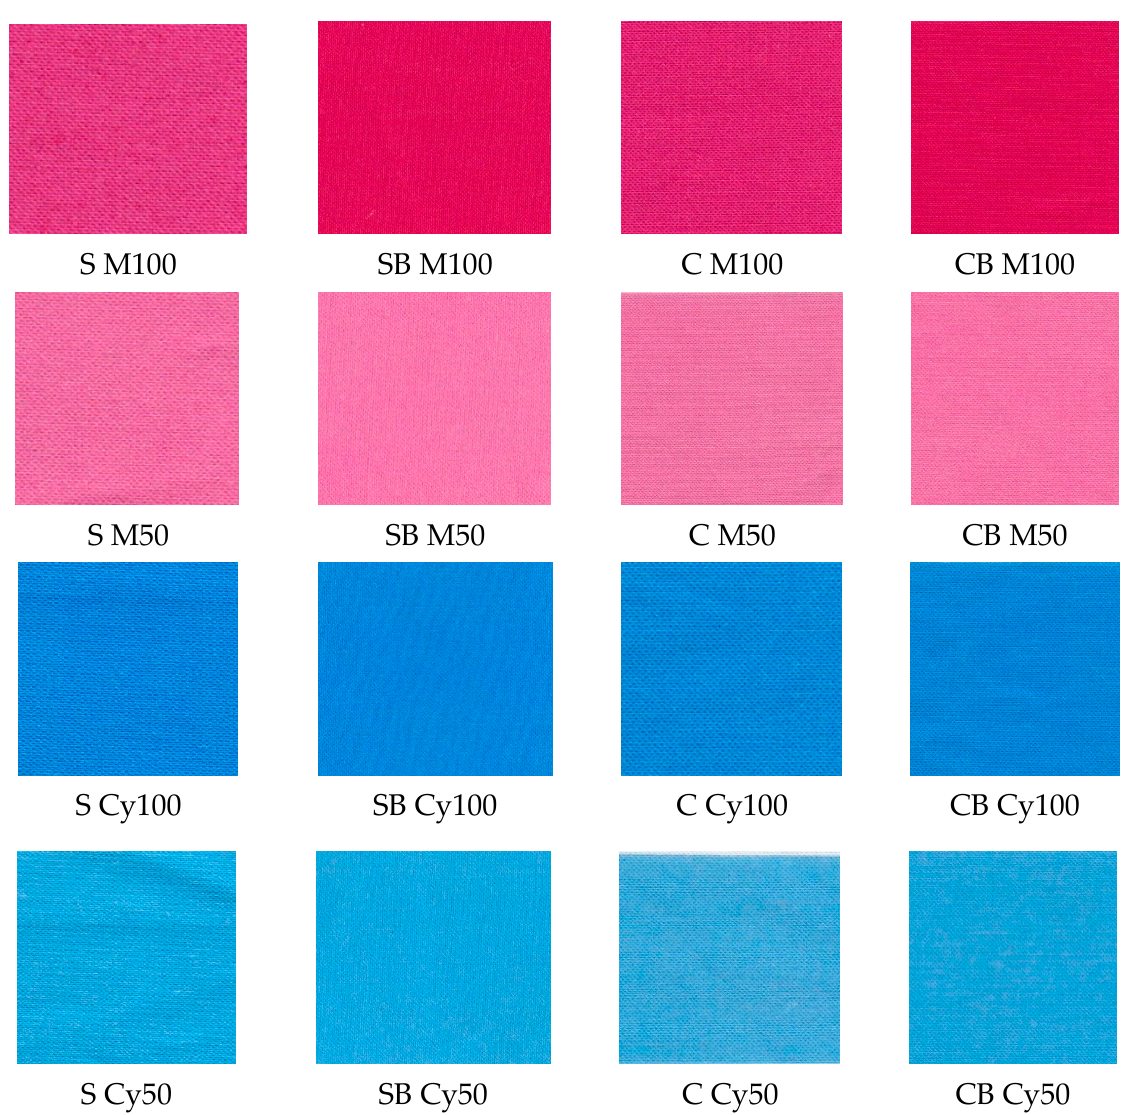
Figure 4. The appearance of printed samples. Table 8. Sample descriptions and labels with code